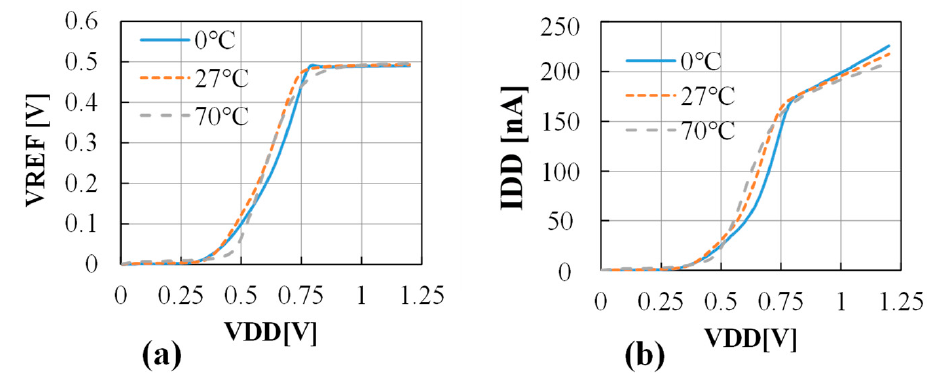
Table 1. Simulation result of V DD at corner conditions.